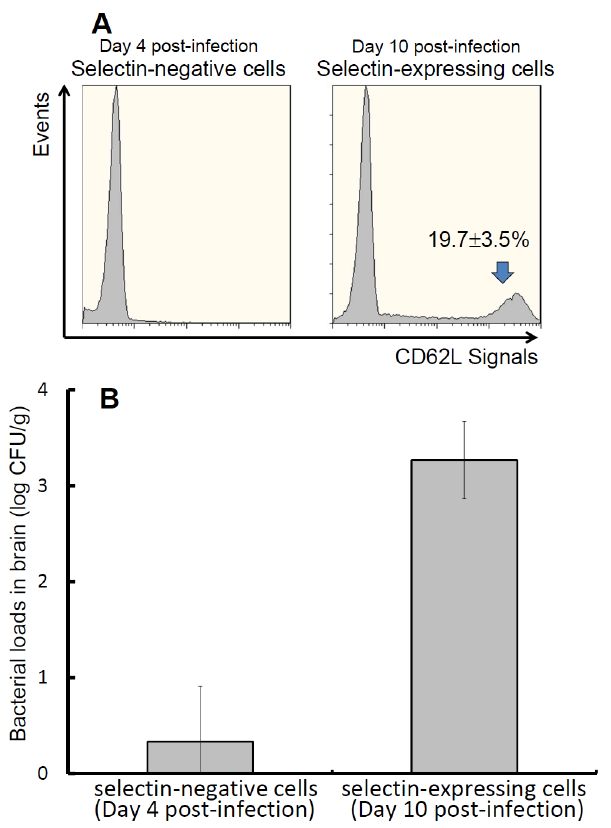
Figure 7. Expression and adoptive transfer of CD11b + selectin- expressing cells. Splenic CD11b + cells were isolated from mice with melioidosis on days 4 or 10 post-infection. The proportions of CD11b + selectin-negative cells (left) and selectin-expressing cells (right) were confirmed (A). The CD11b + cells were obtained from the same mice described above on day 4 (selectin-negative cells) and day 10 (selectin- expressing cells), and adoptive transfer was performed. After 2 d, the bacterial burdens (CFU/g) in the brains of the recipients were determined (B). The values in all experiments are presented as the mean 6 SD of 3 independent duplicate experiments. The limit of detection was 3 CFU/g.